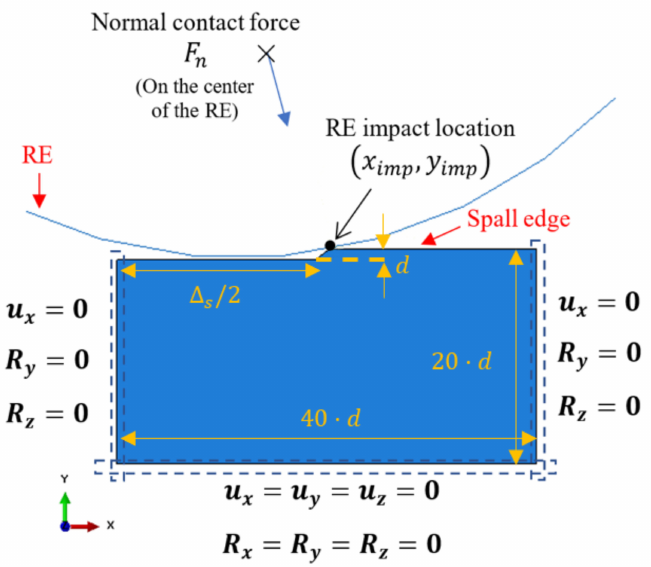
Figure 3. Boundary conditions and geometric parameters of the FE model. The parameters values are listed in Table